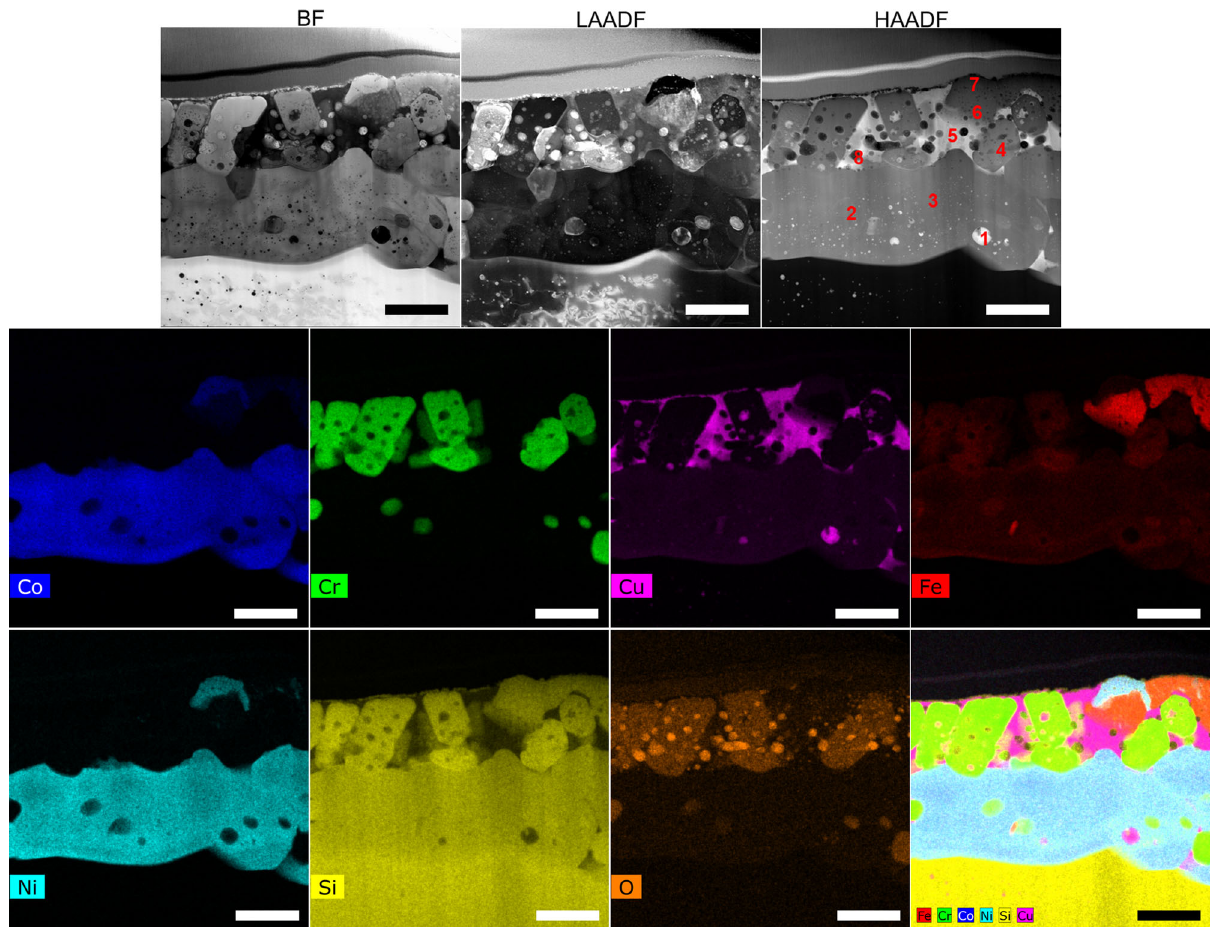
Fig. 4 HEA fi lm grown on Si after high ion irradiation fl uence undergoes large-scale structural change. STEM-BF, LAADF, and HAADF images and EDS maps of the CoCrCuFeNi fi lm grown on a Si substrate after room temperature 11.5 MeV Au-ion irradiation to a fl uence of 6.0 × 10 16 cm − 2 (peak of ~507 dpa). The scale bar length in all images is 800